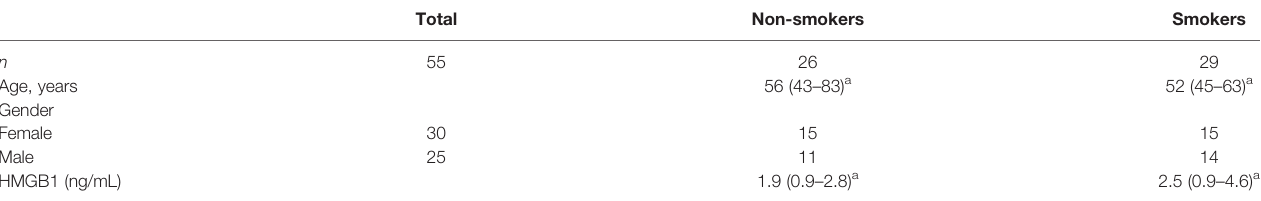
TABLE 2 | Demographic characteristics of control